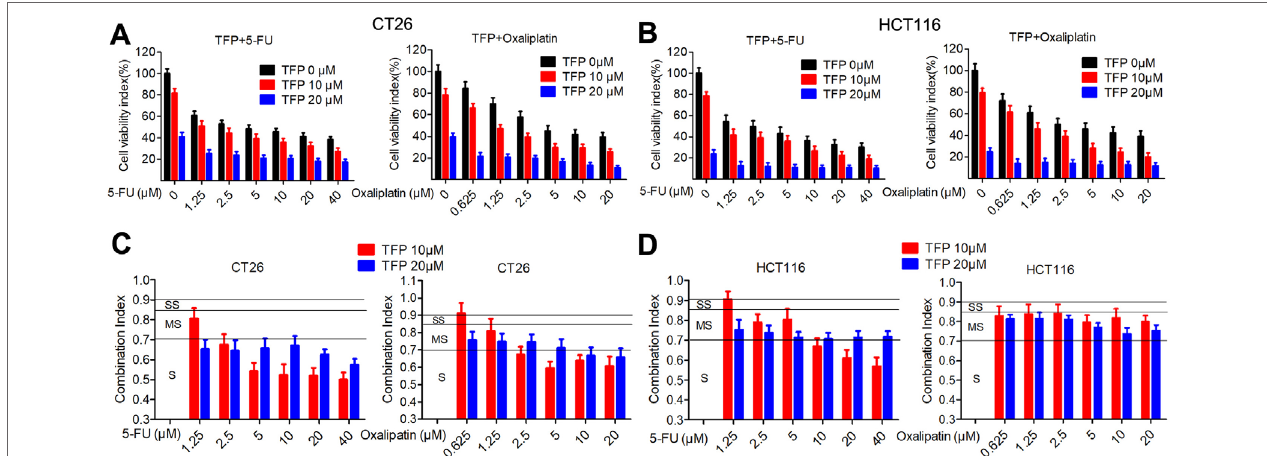
FIGURE 2 | TFP synergizes with 5-fluorouracil and oxaliplatin in CRC in vitro. (A and B) Dose response for TFP and its combination with 5-FU and oxaliplatin in different ratios in CT26 cells (A) and HCT116 cells (B) after treatment for 48 h. Cell viabilities were measured by MTT assay. The cell viabilities of vehicle-treated cells were counted as 100%. (C and D) Combination index (CI) values for TFP and two standard chemotherapy drugs. CI values were calculated using the CompuSyn software based on the inhibition rate at each combination for CT26 cells (C) and HCT116 cells (D) . Slight synergism (SS, CI is between 0.85 and 0.9), moderate synergism (MS, CI is between 0.7 and 0.85), and synergism (S, CI is between 0.3 and